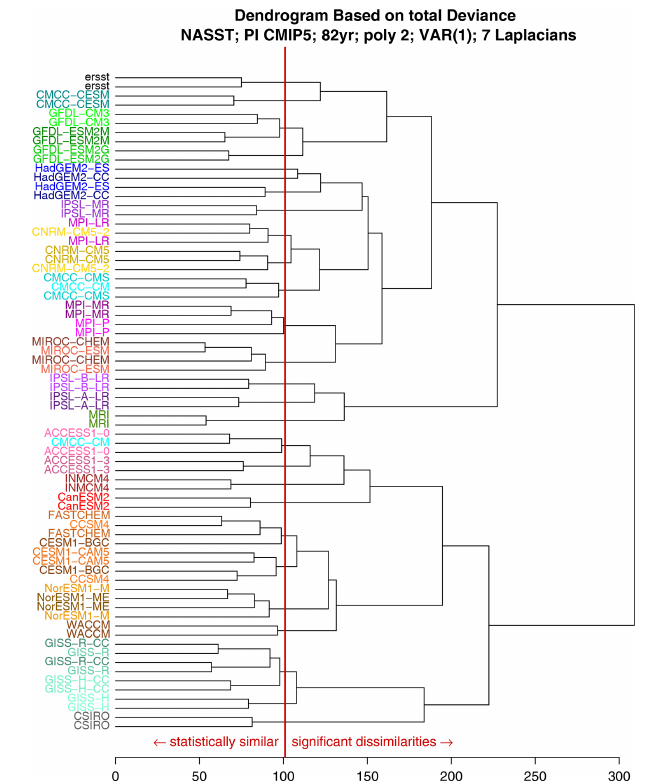
Figure 8. Dendrogram derived from the deviance matrix between all pairs of VAR(1) models estimated from the first and second halves of the 1854–2018 period (the specific year is not relevant for pre-industrial control simulations). The clusters are agglomerated according to the complete-linkage clustering, which uses the maxi- mum deviance between elements of each cluster. The VAR models contain seven Laplacian eigenfunctions, and a second-order poly- nomial in time is removed. The vertical red line shows the 5% sig- nificance threshold for a significance difference in the VAR models.